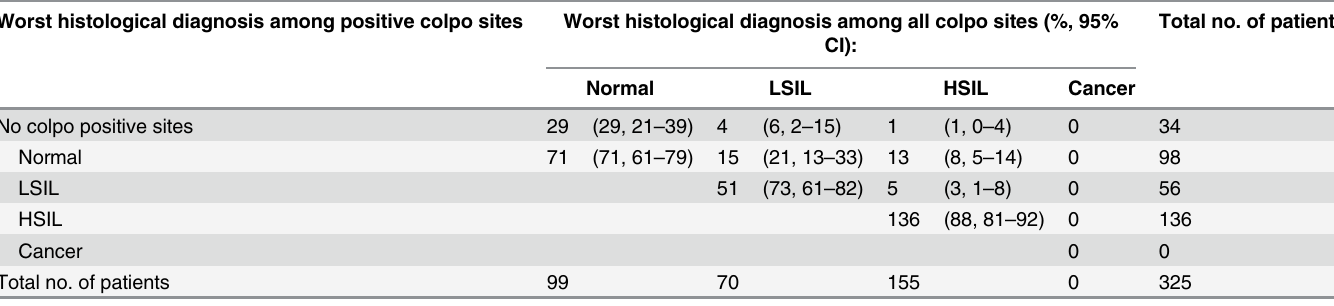
Table 5. Comparison of worst histological diagnosis among sites diagnosed as positive by colposcopy with worst overall histological diagnosis for the 325 Vancouver diagnostic patients. Worst histological diagnosis among positive colpo sites